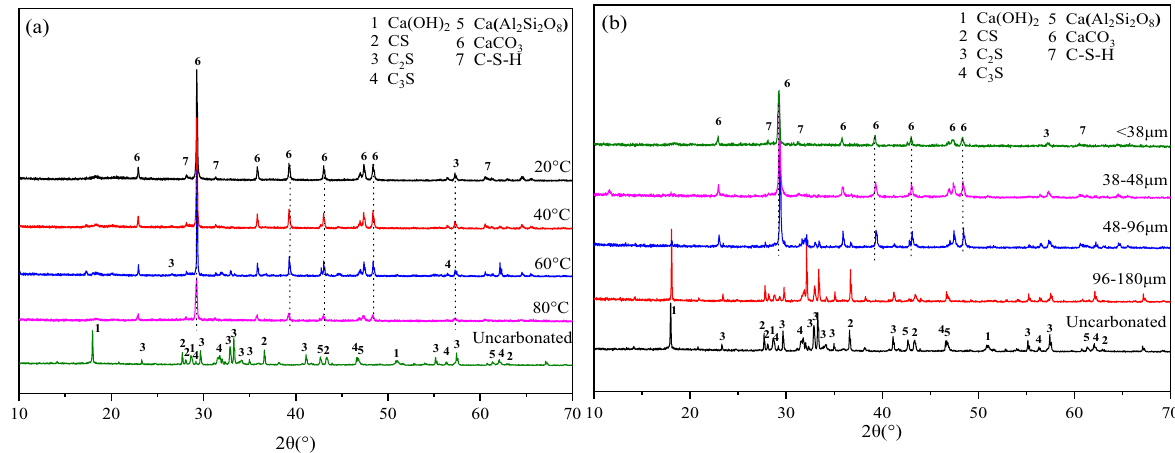
Figure 2. XRD patterns of original LFS and LFS samples after hydration and carbonation: ( a ) at different reaction temperatures, ( b ) at different particle